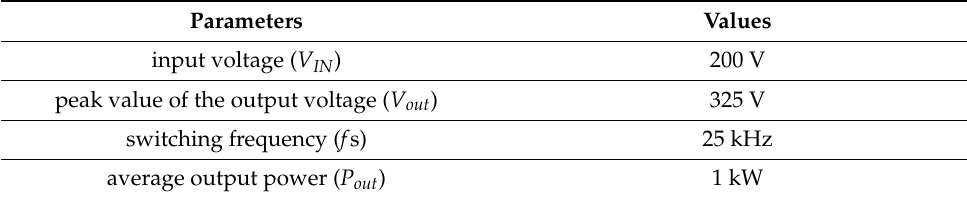
Table 1. Simulation parameters. Parameters Values input voltage ( V IN ) 200 V peak value of the output voltage ( V out ) 325 V switching frequency ( f s) 25 kHz average output power ( P out ) 1